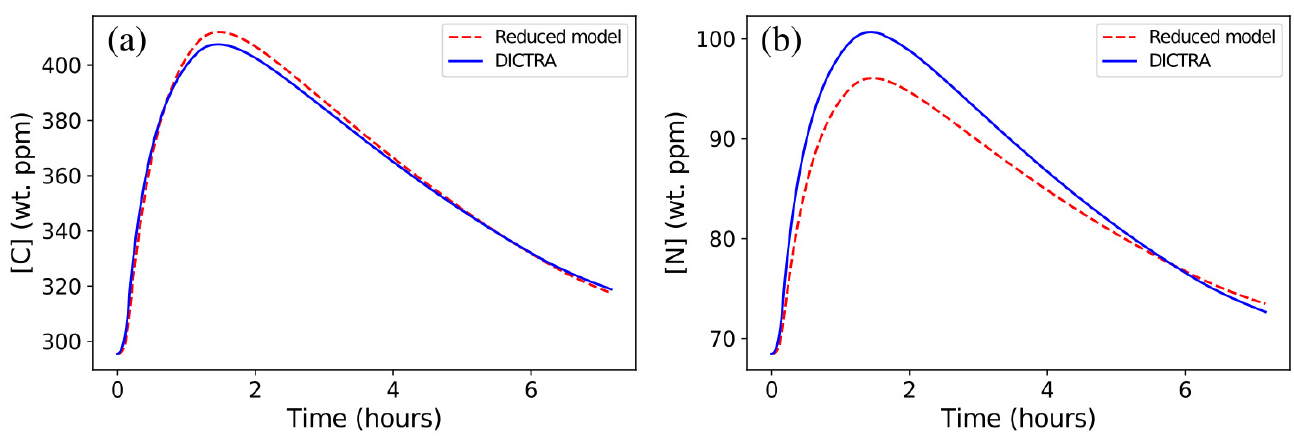
Figure 8. A comparison of mean ( a ) C and ( b ) N contents in austenite ([C] and [N]) calculated using DICTRA (7-element calculation using TCFE9) and that obtained from the reduced model (Equations (4) and (5)) for anisothermal 1473–1373